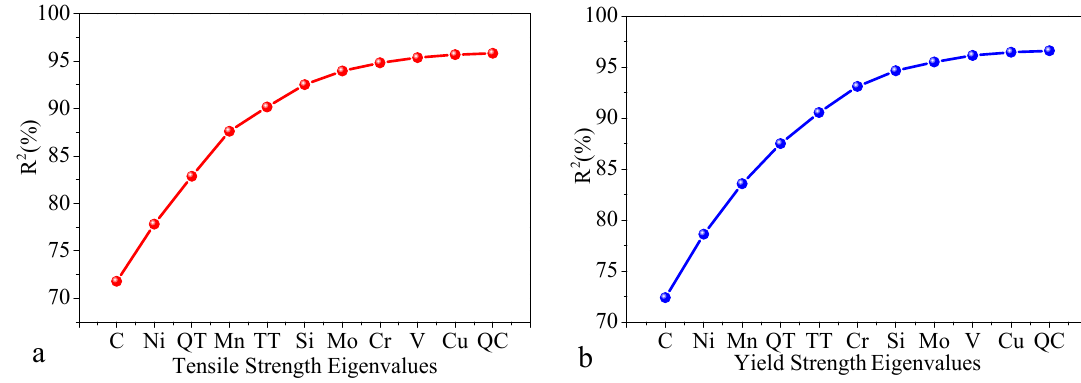
Figure 6. FS to determine the trends of the R 2 values: ( a ) tensile strength and ( b ) yield strength.